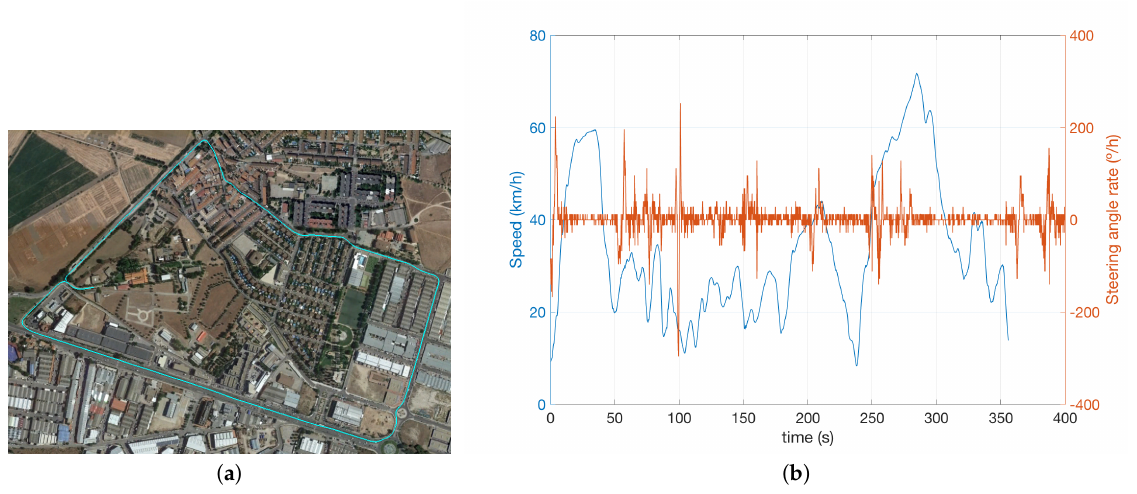
Figure 8. ( a ) Path followed by the vehicle ( b ) Speed and steering angle of the